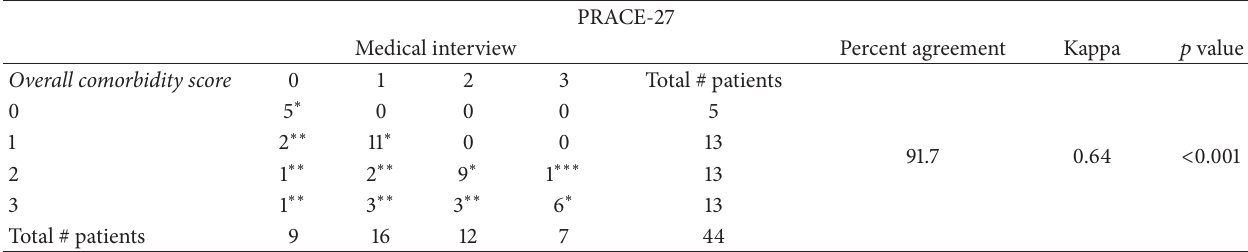
Table 4: Percent agreement and kappa between medical interview (MI) and PRACE-27 assessments for overall comorbidity scores.